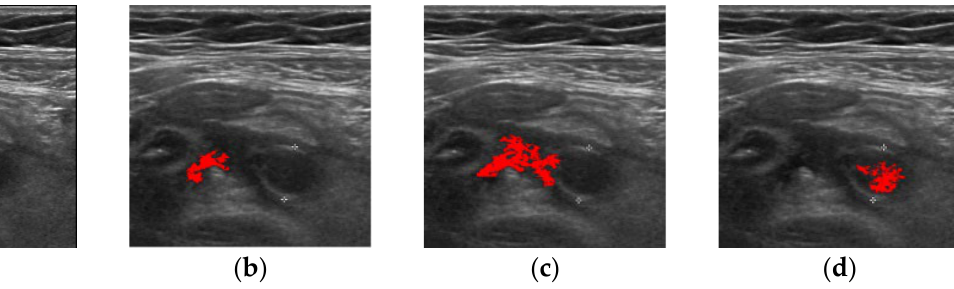
( d ) Figure 6. Comparison of DFCM, ORFCM, and DORFCM. ( a ) Input, ( b ) DFCM, ( c ) ORFCM, and ( d ) DORFCM. Thus, we provide the second performance index is to compare the qualitative perfor- mance between DFCM, ORFCM, and DORFCM with respect to the human expert’s area marking as the ground truth. True positive (TP) is the set of pixels that both human and the software agrees that they belong to the inflamed appendix, false positive (FP) is the set of pixels that only the software thinks they belong to the inflamed appendix, and false negative (FN) is the set of pixels that only human expert classifies as the inflamed appen- dix. The performance index is as following. Precision = TP/(TP + FP) Recall or Sensitivity = TP/(TP + FN) Accuracy = (TP + TN)/all area Table 2 summarizes the performance comparison between DFCM and DORFCM among 91 cases that both methods locate the target object successfully. As one can see, the outlier rejection effect is significant. Table 2. Outlier effect performance comparison (91 cases). Accuracy